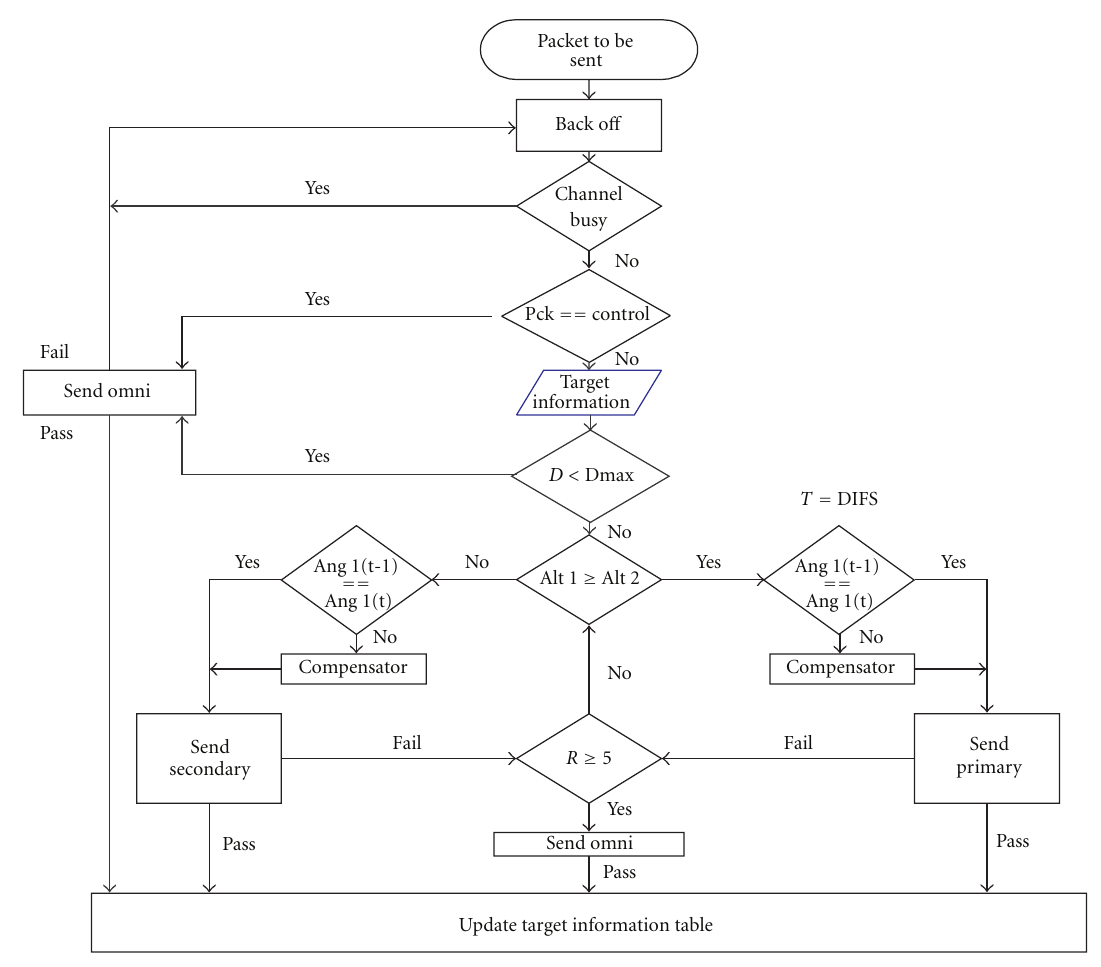
Figure 1: Flowchart of MAC protocol for UAV ad hoc communication network with directional